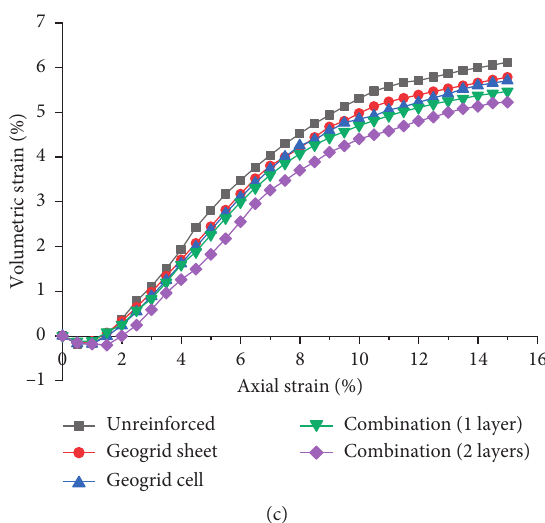
Figure 5: Volumetric strain and axial strain curves in different reinforced forms: (a) σ